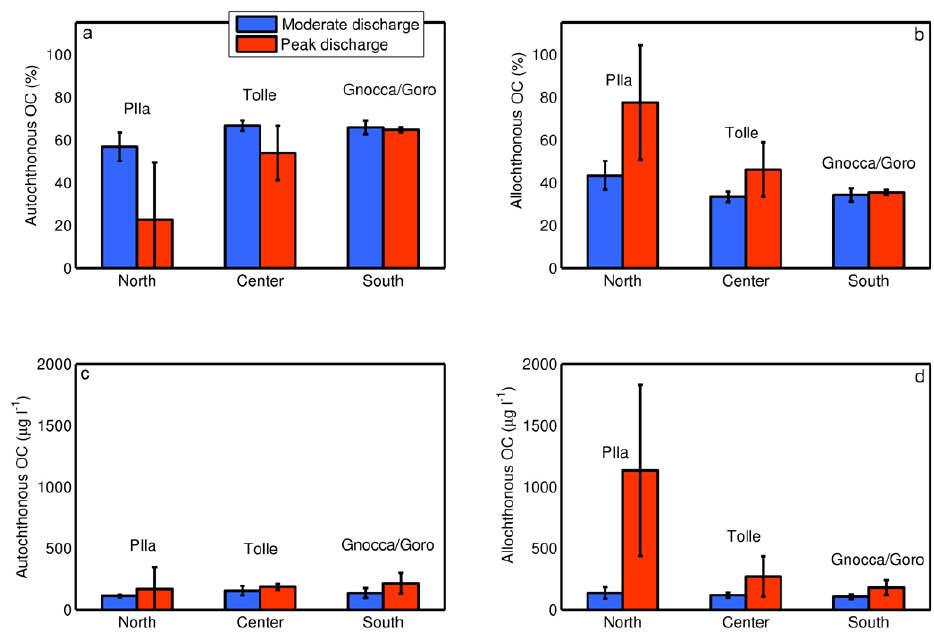
Fig. 12. Results from the end-member mixing model. Surface suspended samples were grouped in three sub-regions according to the latitude: north, center, south. Blue and red bars represent samples collected during moderate and peak discharge, respectively. (a) Fraction of autochthonous OC, (b) Fraction of allochthonous OC, (c) Concentration of autochthonous OC in the surface plume, and (d) Concentration of allochthonous OC in the surface